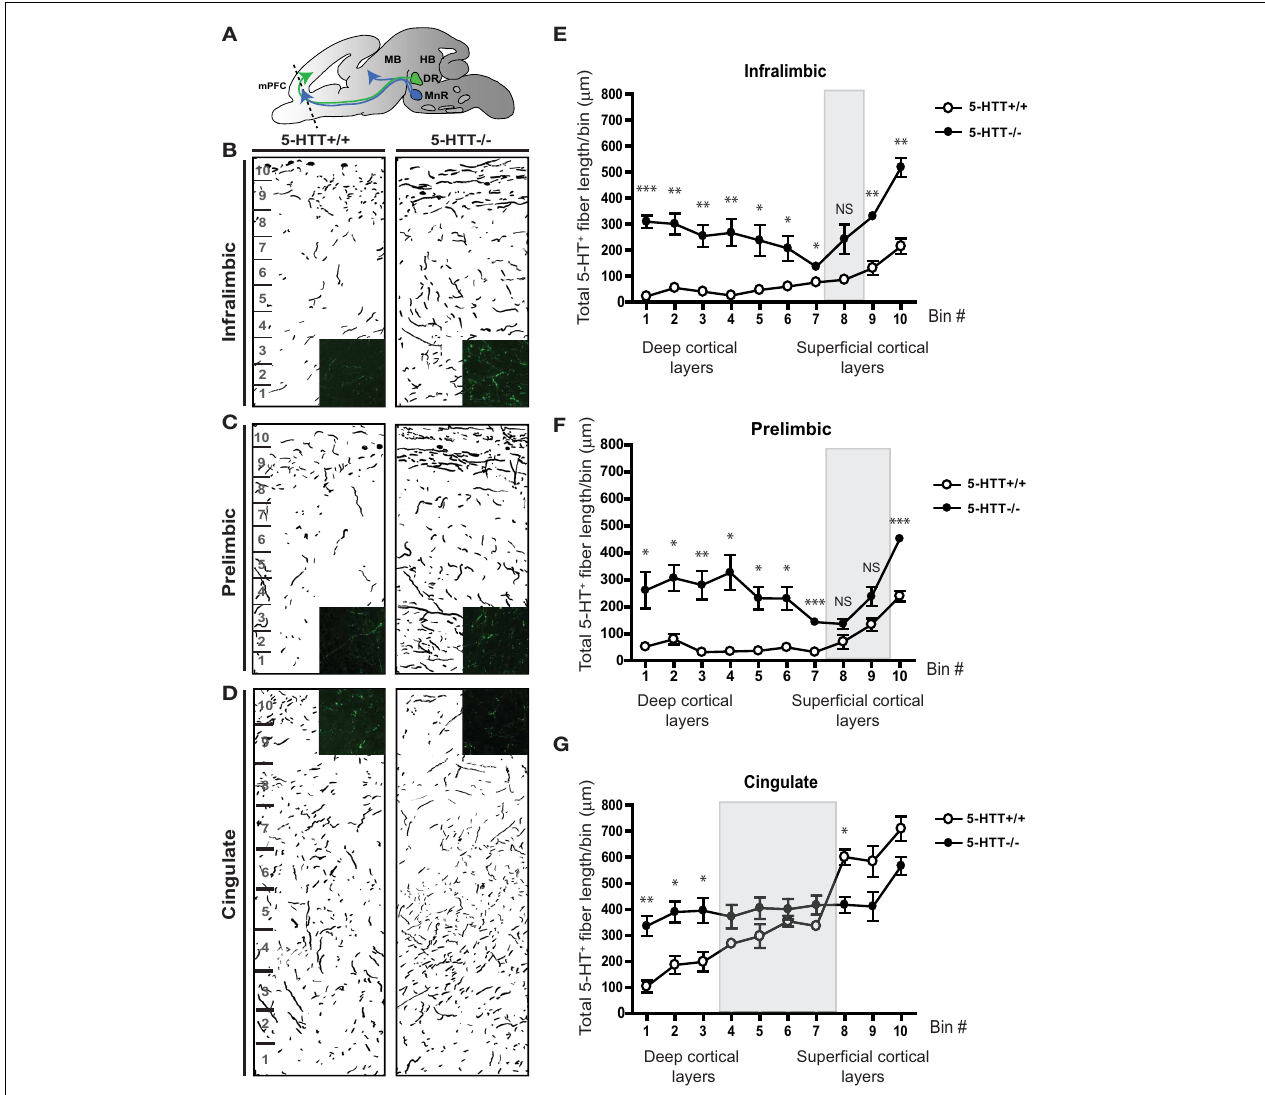
total 5-HT fiber length in μ m in 10 bins dividing the IL as indicated in (B) confirming the qualitative observations as seen in (B) . (F) Quantification of the total 5-HT fiber length in μ m in 10 bins dividing the PL as indicated in (C) confirming the qualitative observations as seen in (C) . (G) Quantification of the total 5-HT fiber length in μ m in 10 bins dividing the Cg as indicated in (D) confirming the qualitative observations as seen in (D) . There is a significant increase in the most deep cortical layers of the IL, PL as well as the Cg of 5-HTT − / − compared to 5-HTT + / + pups ( p < 0 . 05–0.001). The gray boxes indicate the non-significant bins in the more superficial layers. Graphs show average length of 5-HT-positive fibers per bin ± SEM. One-Way ANOVA ( α = 0 . 05), ∗ p < 0 . 05, ∗∗ p < 0 . 01, ∗∗∗ p < 0 .